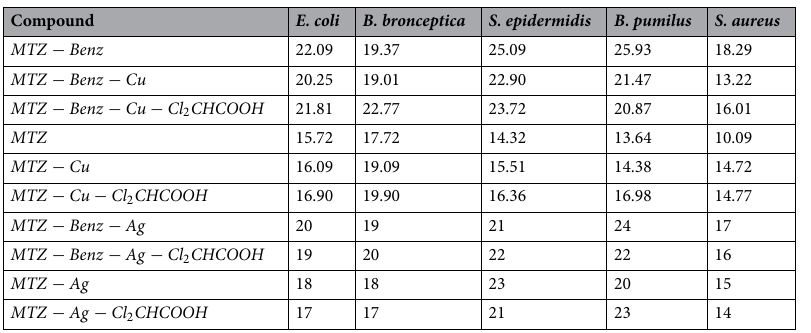
Table 1. Antibacterial activity against the bacteria under consideration is